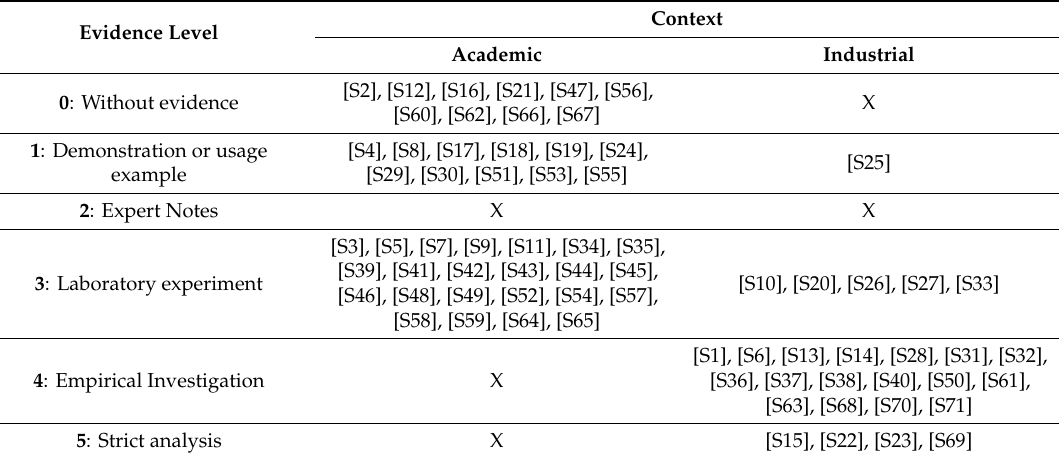
Table 12. Evidence and